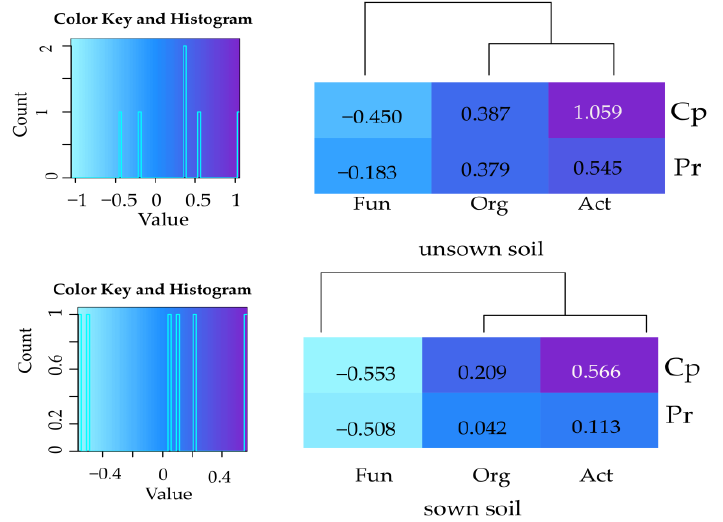
Figure 3. Index of the influence of insecticides (IF in ) on the number of microorganisms. Org — organotrophic bacteria; Act — actinomycetes; Fun — fungi; Pr — soil contaminated with permethrin; Cp — soil contaminated with cypermethrin.